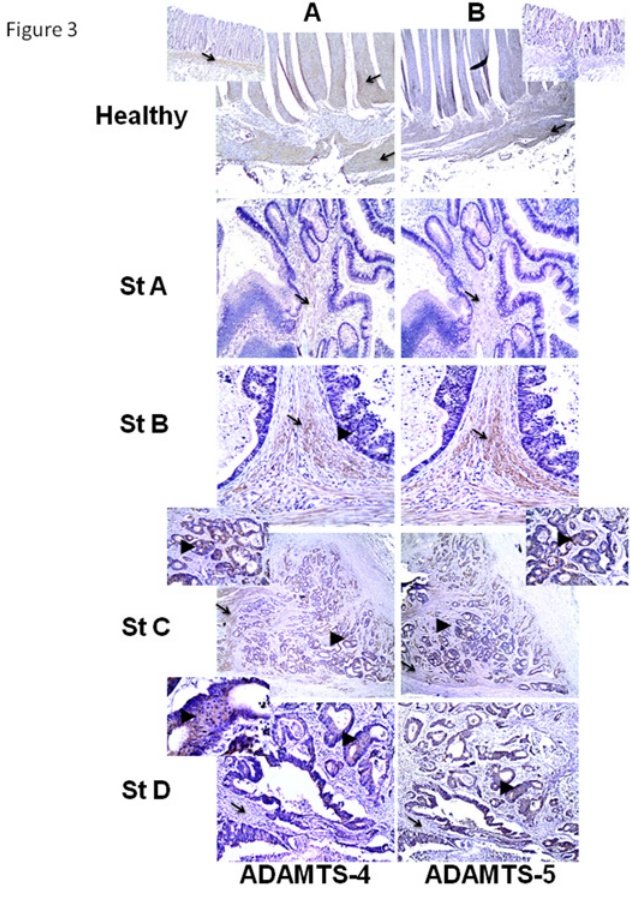
Fig 3. Immunohistochemical localization of ADAMTS-4 and ADAMTS-5 in healthy and in cancerous colon. Healthy colon tissue and cancerous colon of stage A, B, C and D, stained for ADAMTS-4 (A) and ADAMTS-5 (B). (A, magnification; x4, anatomic site; cecum, magnification; x10, anatomic site; cecum, magnification; x20, anatomic site; cecum, magnification; x4, anatomic site; rectum, magnification; x20, anatomic site; rectum and B, magnification; x4, anatomic site; cecum, magnification; x10, anatomic site; cecum, magnification; x20, anatomic site; cecum, magnification; x4, anatomic site; rectum, magnification; x10, anatomic site; rectum), stained for ADAMTS-5. Insets of A show the Mucosa and Submucosa layer on the healthy colon (magnification; x10) and the cytoplasmic localization of ADAMTS-4 in cancer cells of stage C and D (magnification; x20 and x40, respectively). Insets of B show the Mucosa and Submucosa layer on the healthy colon (magnification; x10) and the cytoplasmic localization of ADAMTS-5 in cancer cells of stage C (magnification; x20). Arrows in healthy colon show the expression of ADAMTS in the muscle tissue. Arrows in cancerous colon show the expression of ADAMTS in stroma, while arrowheads show the expression of ADAMTS in cancer